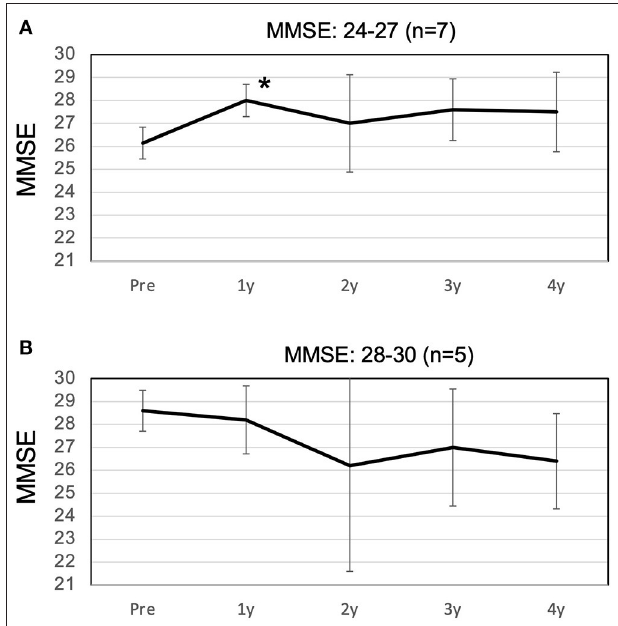
FIGURE 3 | Changes in the high and low MMSE groups over 4 years. (A) In the low MMSE group, with a preoperative MMSE of 24-27, the MMSE improved significantly to 28.0 at 1 year postoperatively, with only a slight decline thereafter. (B) In the high MMSE group, with a preoperative MMSE of 28-30, the MMSE decreased slowly until 4 years postoperatively. There was no difference between the two groups at 4 years postoperatively. MMSE, Mini-Mental State Examination. Asterisks indicate significant differences compared to preoperative values ( p < 0.05).